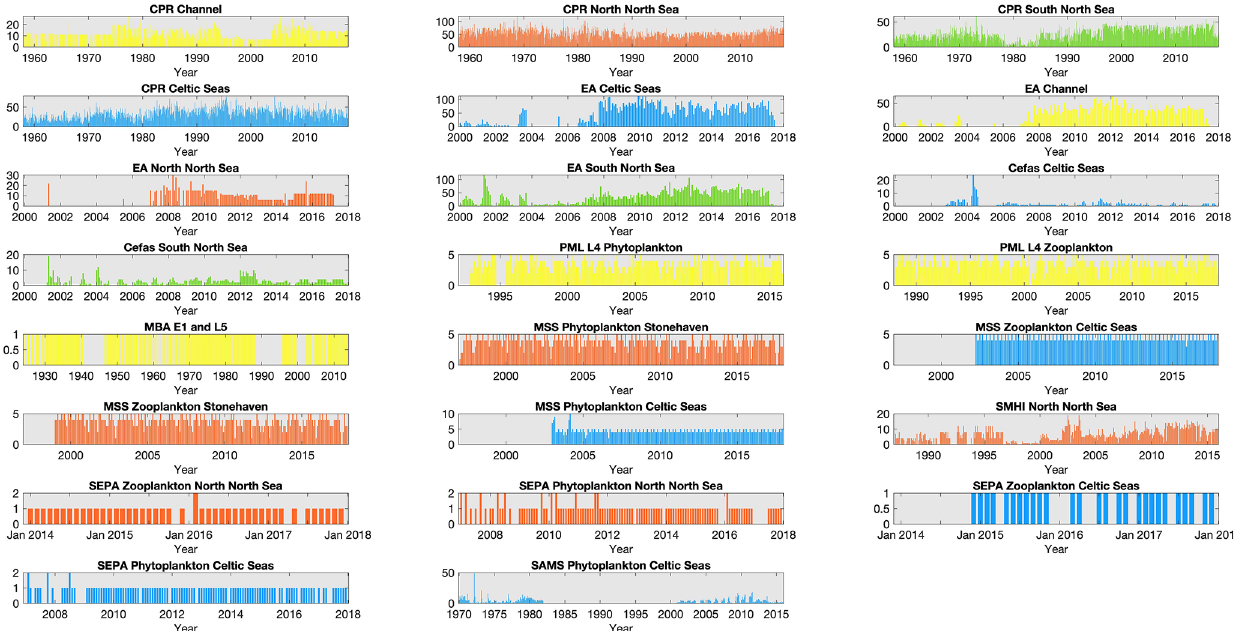
Figure 2. Sampling effort of each dataset within each region: number of sampling time points collected per month for each dataset within each of the regions defined in Fig. 1, except for MSS stations in the northern North Sea where only Stonehaven is shown as an example of the three MSS stations in that region. Note that axis limits are not fixed between panels. Bar colour indicates spatial region (see Fig. 1); blue: Celtic Seas; red: northern North Sea; green: southern North Sea; light yellow: English Channel.